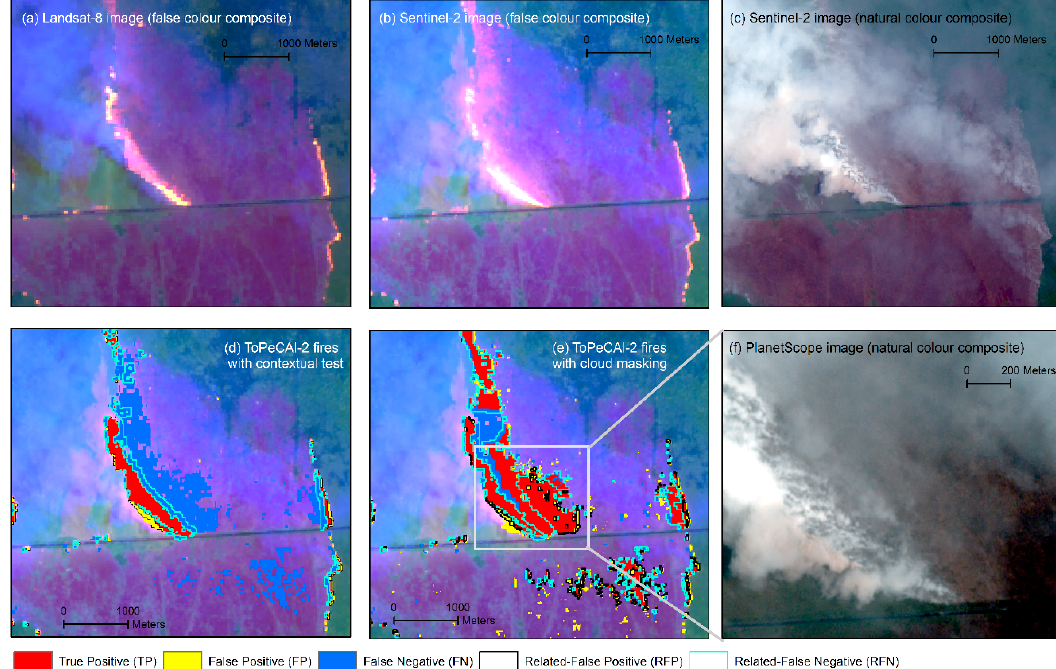
Figure 12. ( a ) RGB image of Landsat-8 with SWIR-2 band as Red layer, SWIR-1 band as Green layer, and Red band as Blue layer. Landsat-8 was acquired on 28 September 2018 at 2:34 Universal Time Coordinated (UTC) over Central Kalimantan’s peatland; the dark straight line below the fires features (light yellow) is a river canal; green is vegetation and reddish purple is burnt area; ( b ) The same RGB composite image with Figure ( a ), but for Sentinel-2, which was acquired nine minutes before Landsat-8; ( c ) Natural RGB composite of Sentinel-2 on the same data with Figure ( b ); ( d ) Peatland fires from ToPeCAl-2 with contextual test applied to Sentinel-2 image compared with ToPeCAl-1 fires from Landsat-8 overlaid on RGB image of Sentinel-2; ( e ) the same with Figure ( d ) but from ToPeCAl-2 with cloud mask; ( f ) Natural composite of PlanetScope image on 28 September 2018 at 2:47 UTC showing smoke emanating from fire areas (white square) in Figure ( e ).